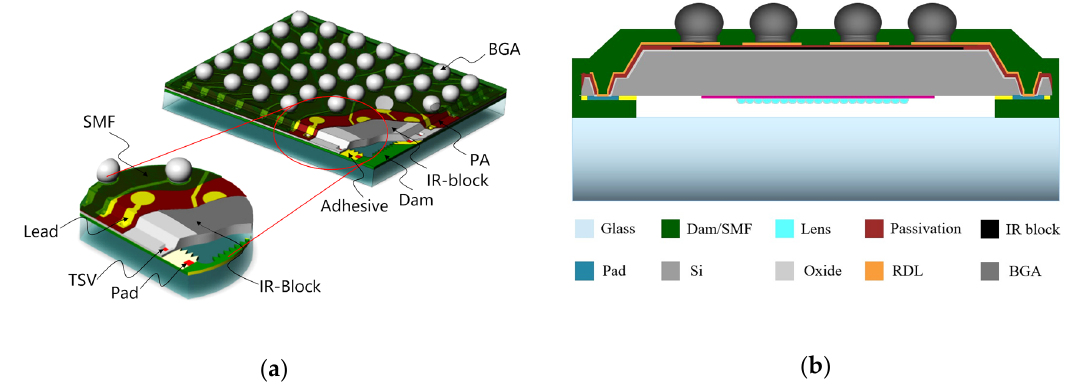
Figure 2. The schematic of the package ( a ) 3D view of the CIS-WLCSP structure; ( b ) Cross-section of the CIS-WLCSP structure.